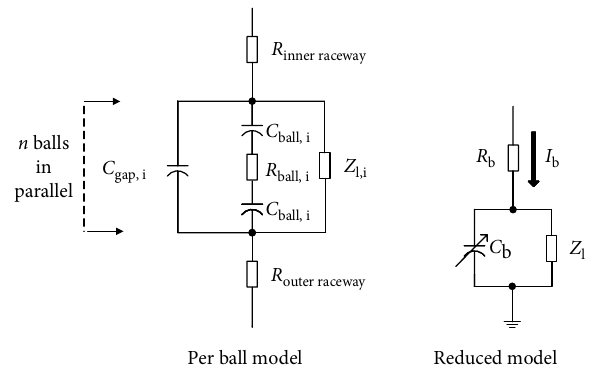
Figure 2: Ball per ball and reduced model of the mechanical bearing, adopted from